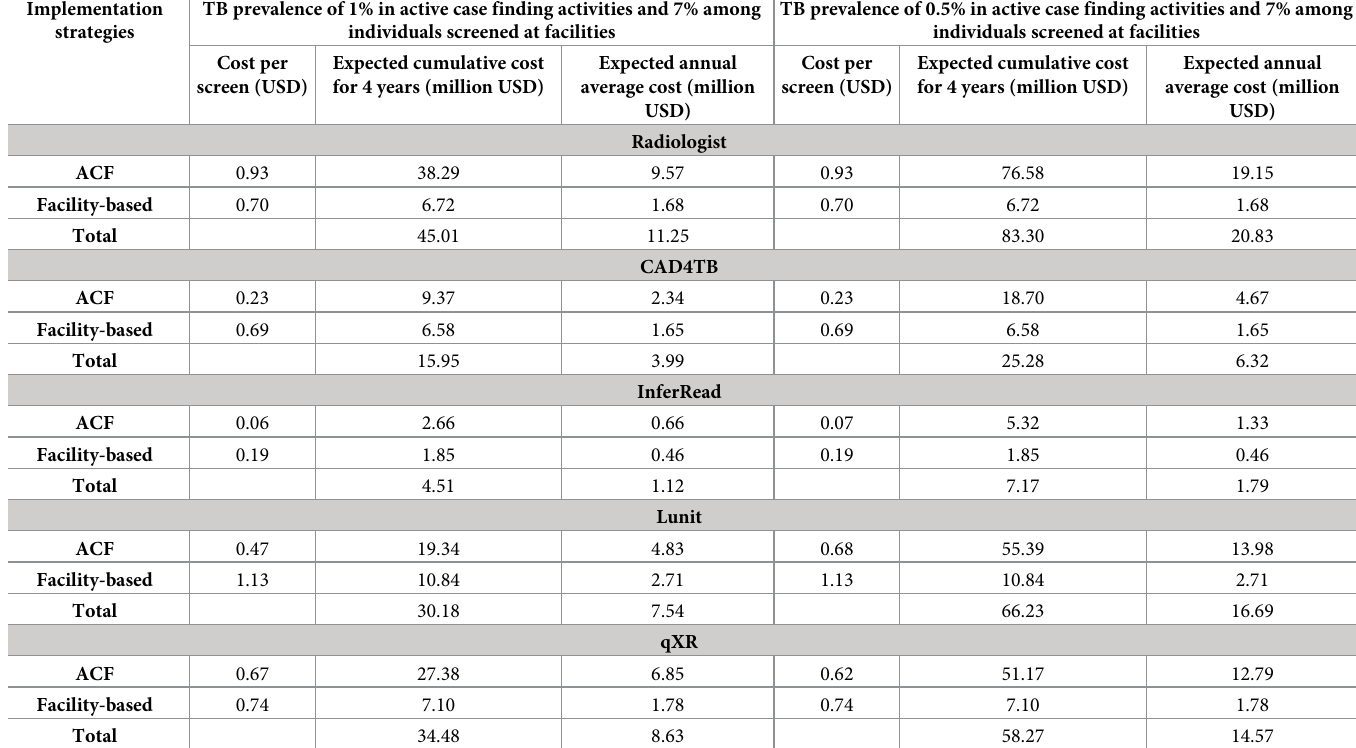
Table 3. Sensitivity analysis: Expected incremental cost for scale-up at national level assuming a TB prevalence of 1% and 0.5% in active case finding activities and 7% among individuals screened at facilities. Implementation